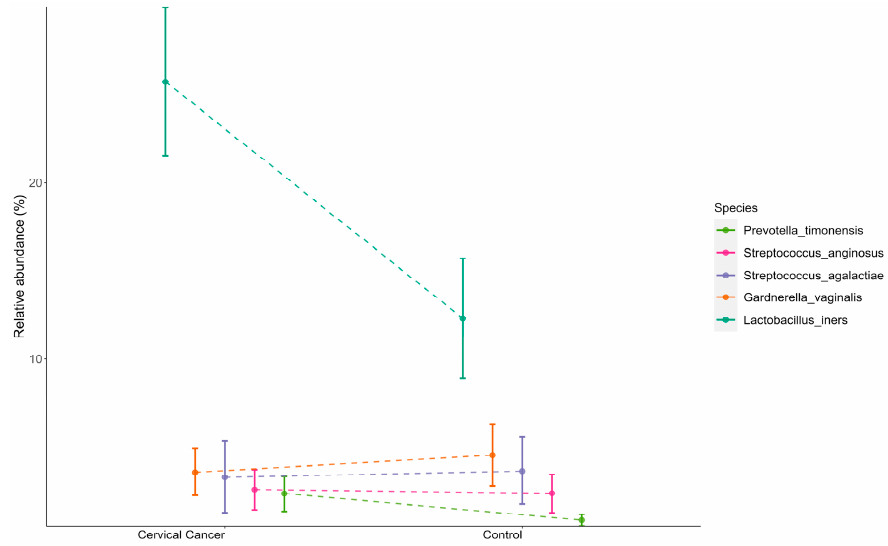
Figure 3. An illustration of a bar plot showing the relative abundance of diseased and control groups at the genus level (cervical cancer—left; healthy control—right).